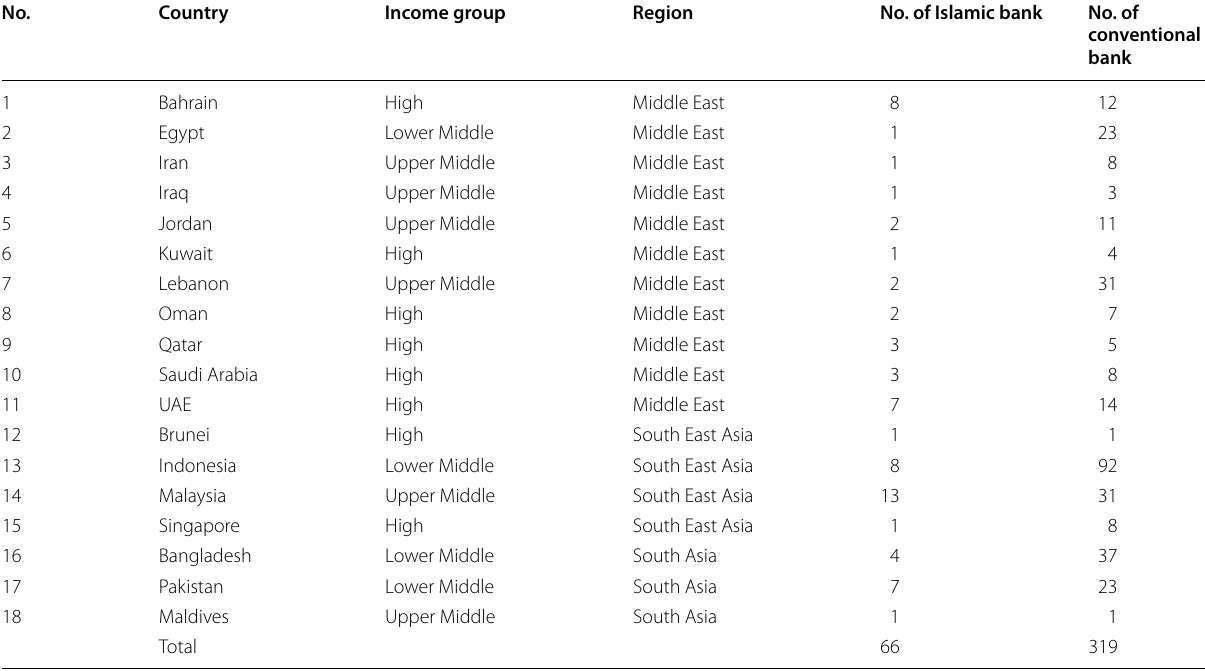
Table 2 Sample data. Source : Fitch Connect database